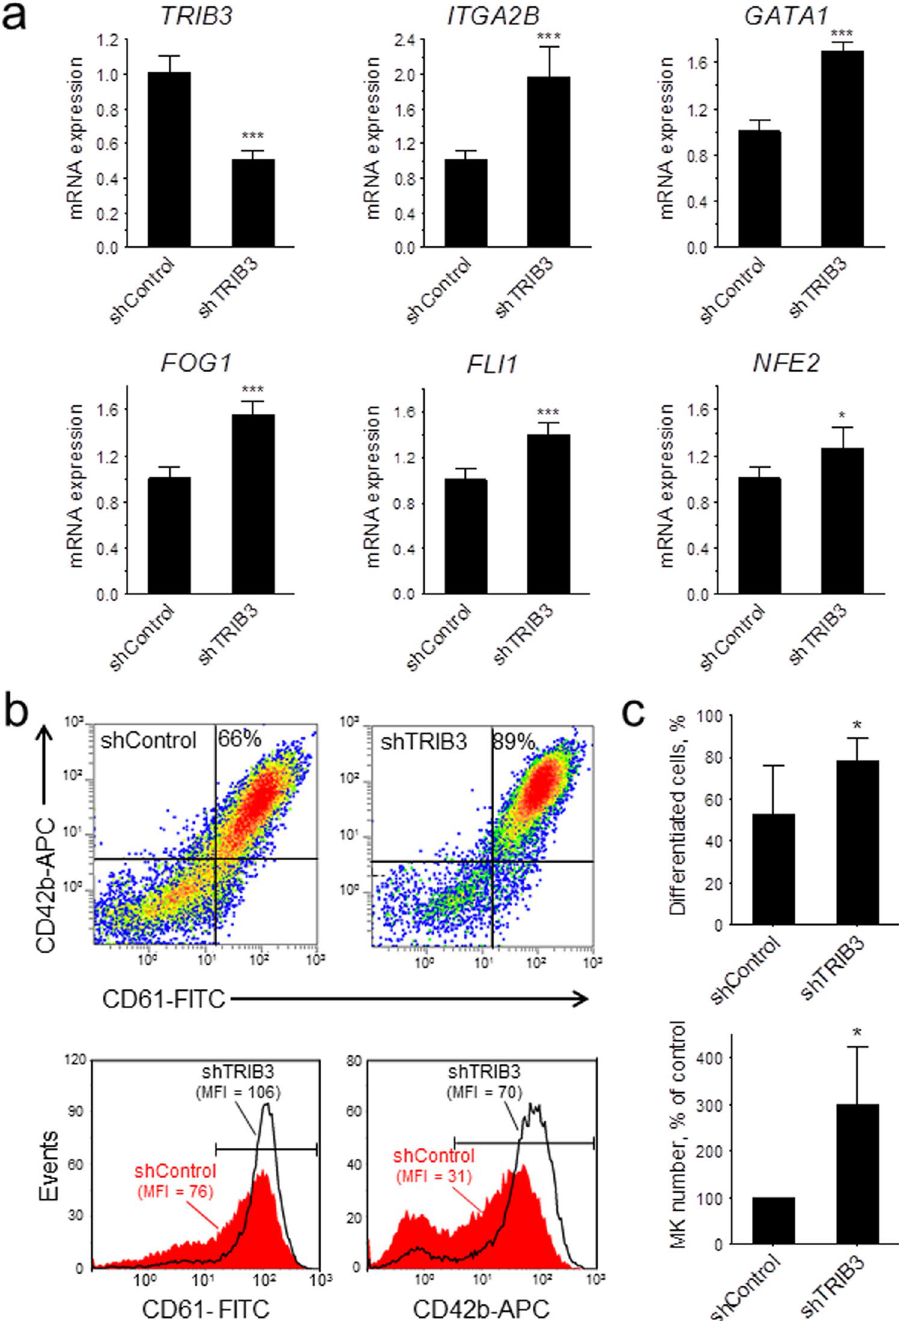
Figure 3. TRIB3 silencing enhances the megakaryocytic differentiation of primary haematopoietic cells. shRNA-transduced cells (shControl and shTRIB3.4) were grown for 7 days with 40 ng/mL TPO and then analysed for mRNA and surface marker expression. ( a ) mRNA levels for the indicated genes are depicted relative to the respective levels in shControl. Error bars denote SD of pooled Q-PCR data from two independent experiments (n = 6). ( b,c ) Flow cytometric analysis of megakaryocytic differentiation. ( b ) Representative density plots display the percentages of differentiated cells and histogram plots display the median fluorescence intensities of the cells encompassed within the horizontal markers. ( c ) Results of four independent experiments are presented as mean ± SD. The top panel shows the percentages of differentiated cells in the transduced cultures and the bottom panel shows the total number of differentiated cells, expressed as a percentage of those in shControl. * P < 0.05 and *** P <